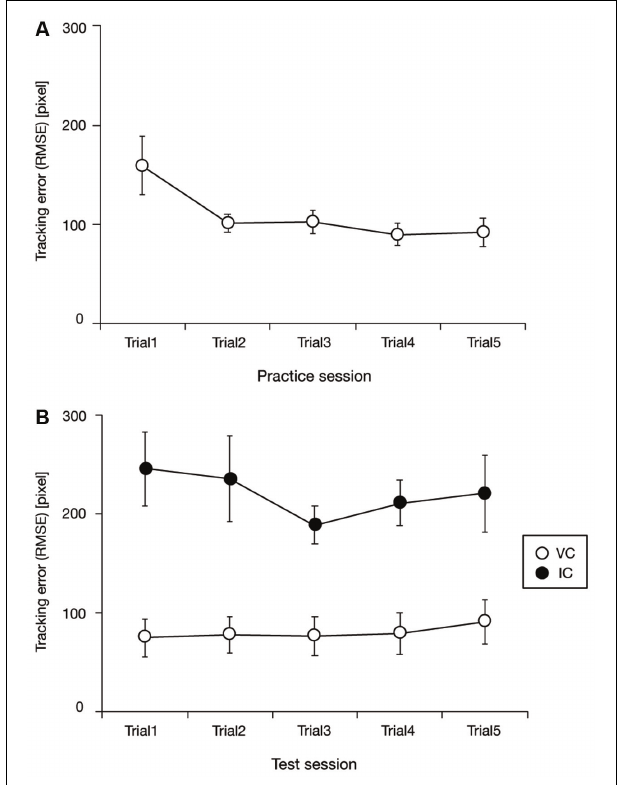
FIGURE 2 | Tracking performance as a function of trial in the practice session (A) , and tracking performance as a function of trial for each task condition in the test session (B) . Tracking performance tended to decrease and then plateau during the practice session. In the test session, tracking performance seems to be worse in the invisible cursor condition (IC) than in the visible cursor condition (VC). RMSE denotes the root mean square of the position error. Error bars represent 95% confidence